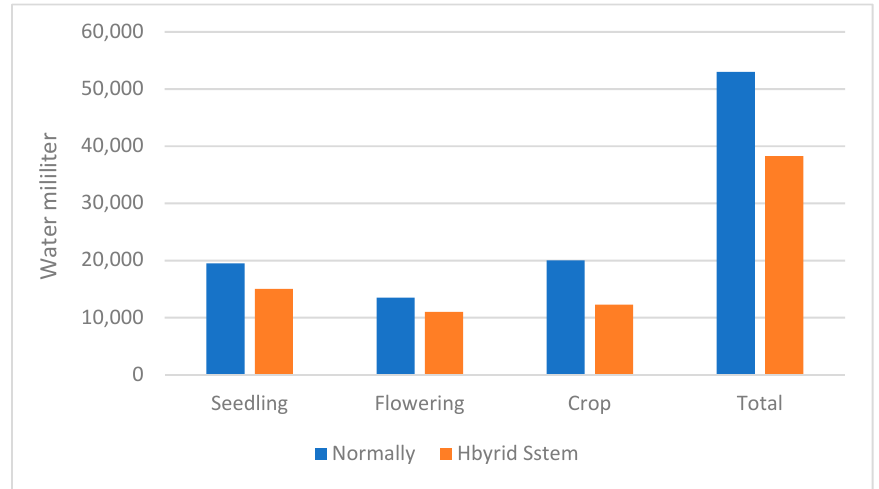
Figure 21. Comparison of water consumption using irrigation.